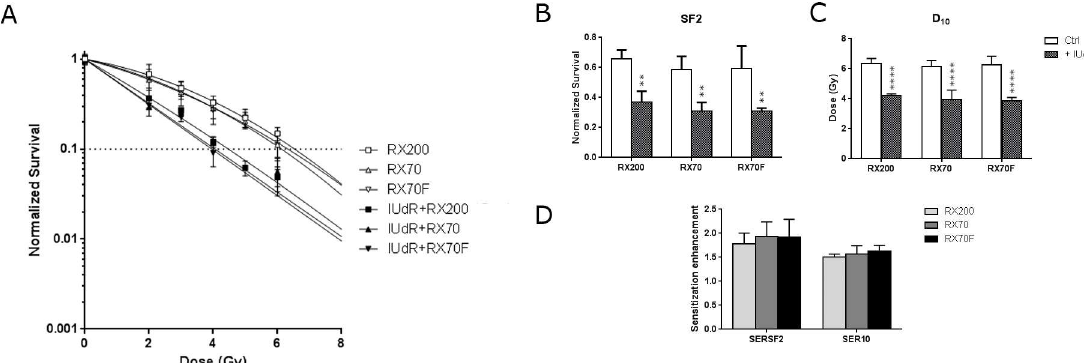
Fig 2. Impact of low energy X-rays on IUdR radiosensitization. (A) Cell survival assays obtainedwith F98 cells subjectedor not to IUdR pretreatment and exposedto the RX200(72.5 KeV), RX70 (42.5 keV) or RX70F (50 keV) beam. The corresponding (B) survivingfractions at 2Gy (SF2), (C) doses giving 10% of cell survival (D 10 ) and (D) sensitizationenhancement ratios (SER) were calculated(n (cid:21) 3).